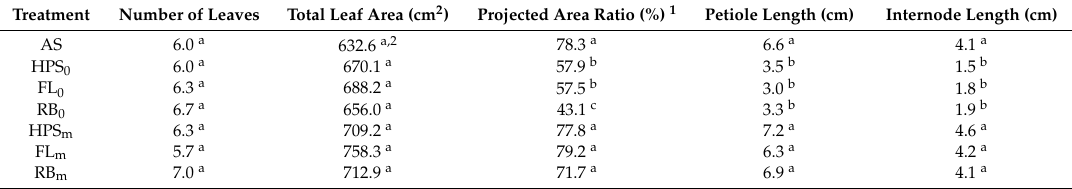
Table 3. Photomorphogenic characteristics of cucumber plants grown under each treatment. See Section 2.4 for treatments.